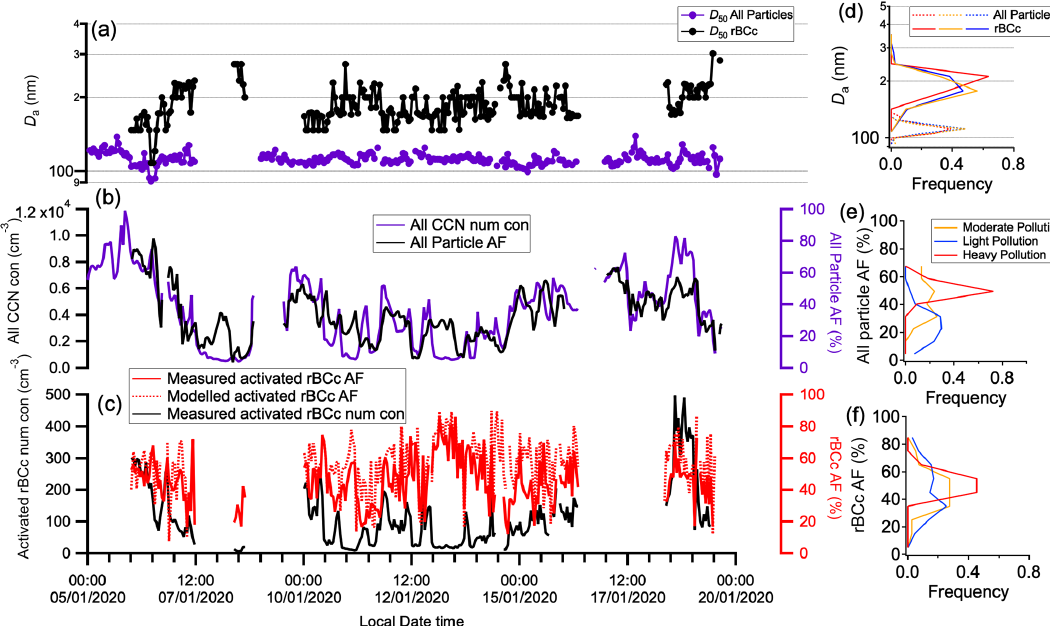
Figure 8. CCN activities of all particles and rBCc. (a) Time series of D 50 for all particles and rBCc. (b) Time series of all CCN number concentrations and the activation fractions of all particles. (c) Time series of measured number concentrations of activated rBCc, and acti- vation fractions of rBCc from two methods. (d) Frequency of D 50 for all particles and rBCc. (e) Frequency of the activation fraction of all particles. (f) Frequency of measured activation fraction of